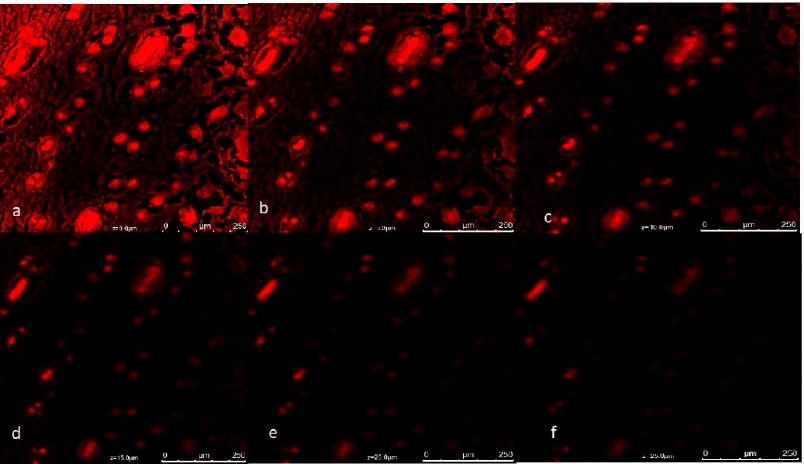
Figure 7. Confocal laser scanning microscopy (CLSM) images showing the penetration and distri- bution of the formulation at ( a ) 0, ( b ) 5, ( c ) 10, ( d ) 15, ( e ) 20, and ( f ) 25 μ